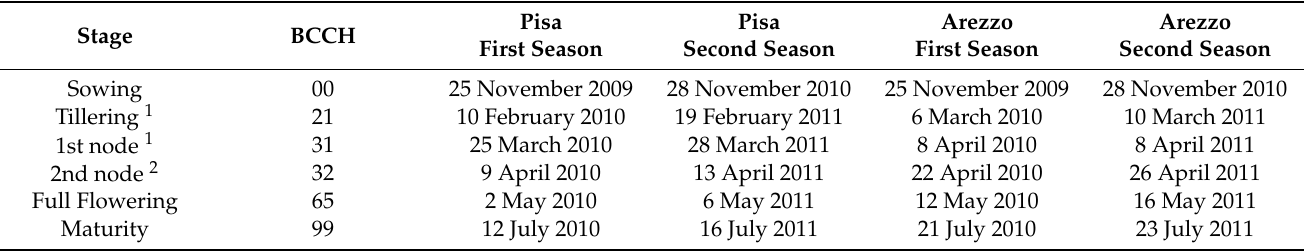
Table 1. Durum wheat growth stages in the two growing seasons (2010 and 2011) at the two locations.